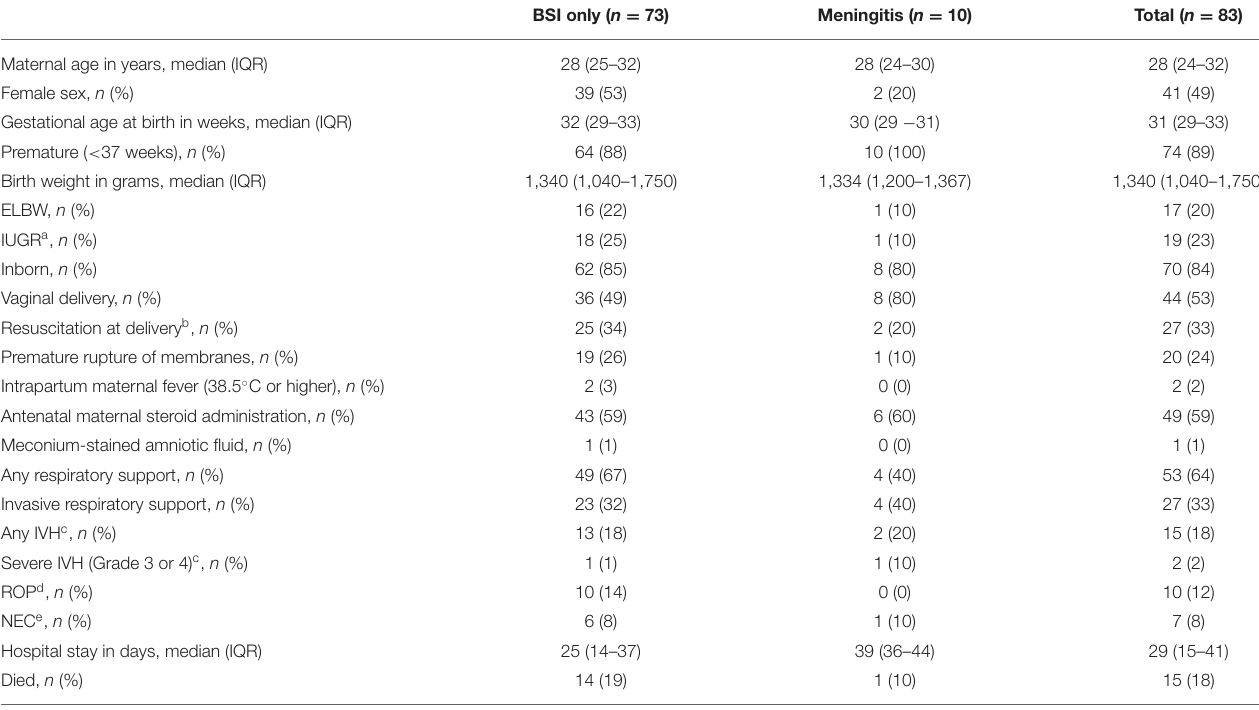
TABLE 1 | Clinical and demographic characteristics of neonates with culture-positive bloodstream infections or meningitis. BSI only ( n = 73) Meningitis ( n = 10) Maternal age in years, median (IQR)